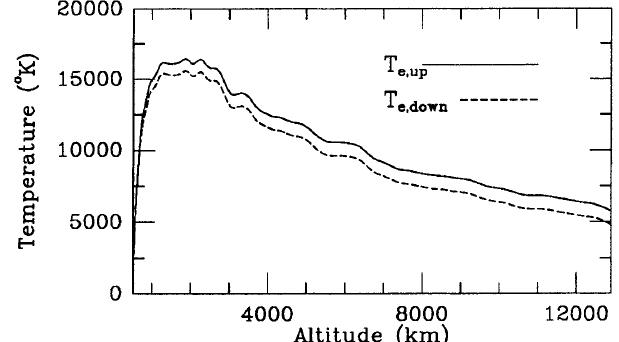
Fig. 6. Parallel temperatures for upwardly and downwardly moving electrons, the k subscript has been omitted for simplicity